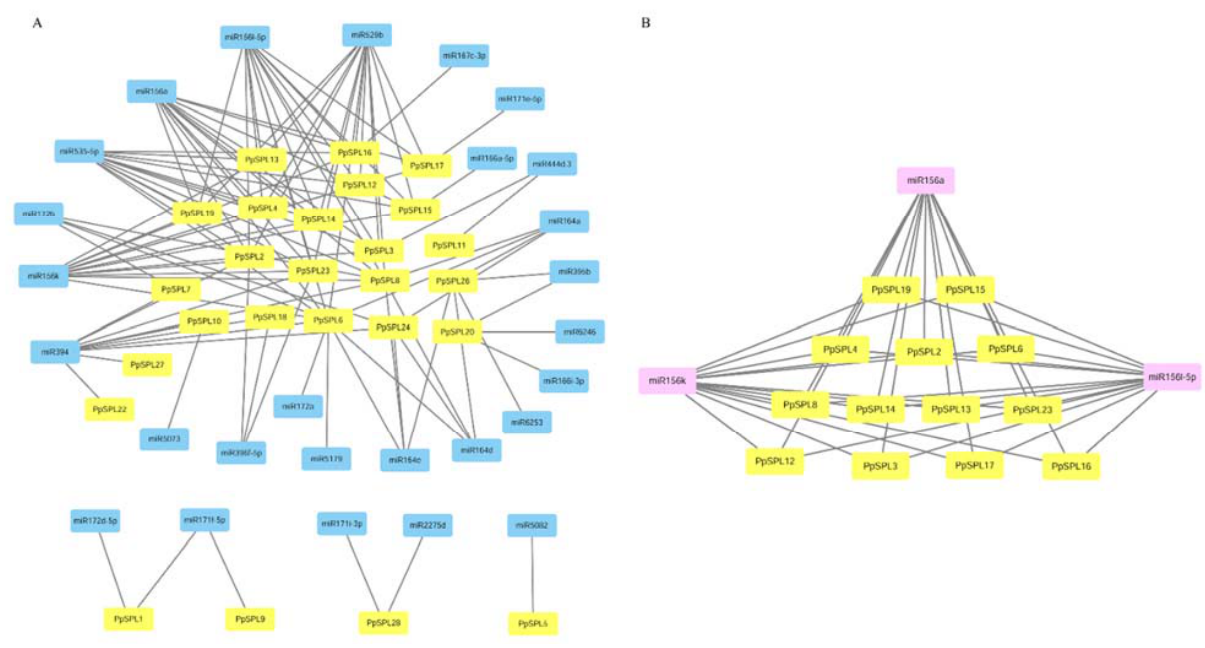
Figure 4. miRNA target analysis of 28 PpSPLs . ( A ) The relationship of 28 PpSPLs with all kinds of miRNAs. ( B ) The miRNA156 ‐ targeting PpSPLs . The yellow icons represent PpSPLs , the blue icons represent miRNAs , and the pink icon represents miRNA156 .